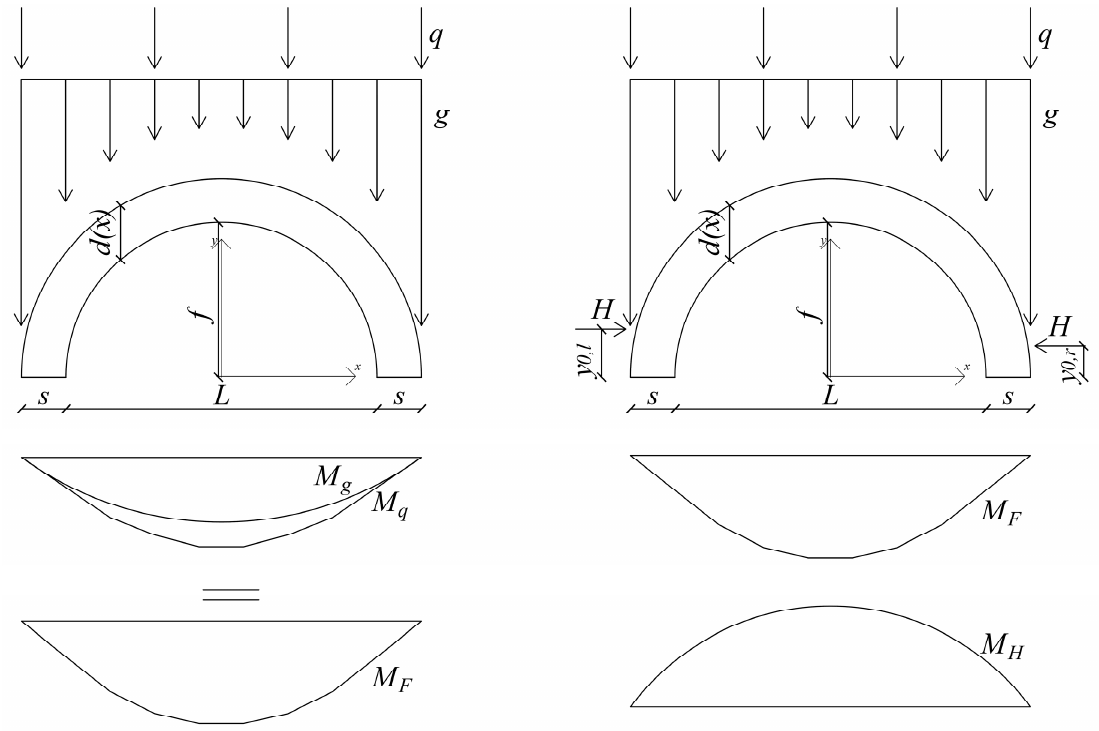
Figure 3. Applied load and moment distribution on the arch.